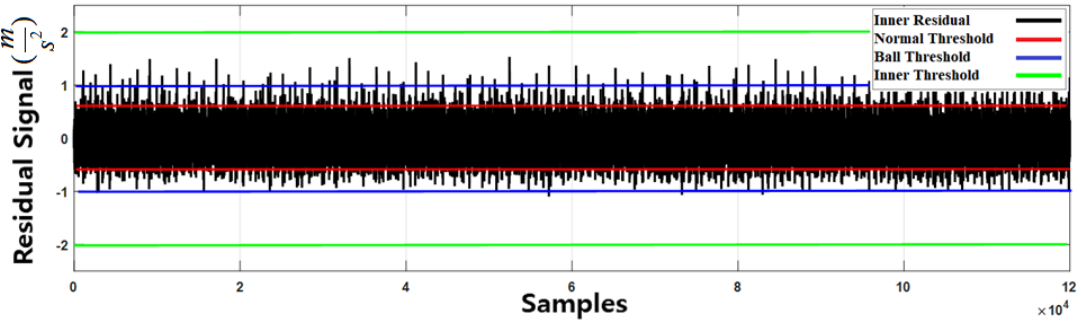
Figure 14. Inner residual signal, normal threshold, ball threshold, and inner threshold signal for the inner faulty condition with a crack width of 6 mm.